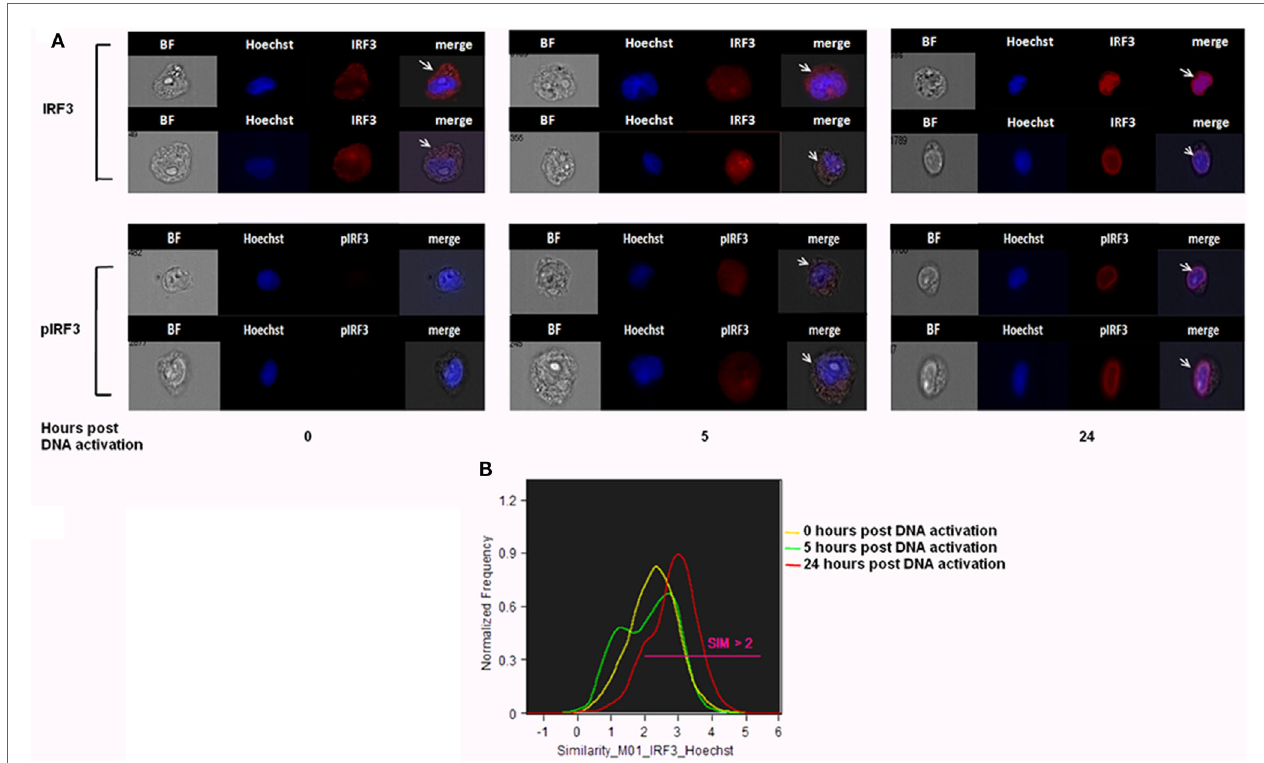
FIgURe 5 | IRF3 and phosphorylated IRF3 (pIRF3) translocation into the nucleus upon Plasmodium falciparum ( Pf )-genomic DNA intake by recipient host monocytes. (A) THP-1 cells were transfected with Pf gDNA for 5 or 24 h. Cells were next fixated and labeled with Hoechst (DNA dye), IRF3 (upper panel), or pIRF3 (bottom panel) antibodies, imaged and analyzed by imaging flow cytometry at different time points. Representative results from at least three experiments are shown n = 2*10 5 . (B) Similarity values between the IRF3 and nuclear image. Values over 1.5 are considered as co-localization. Representative results from at least three experiments are shown. T -test ( p < 0.001) analysis for similarity values between 24 h and not treated and between 24 and 5 h was